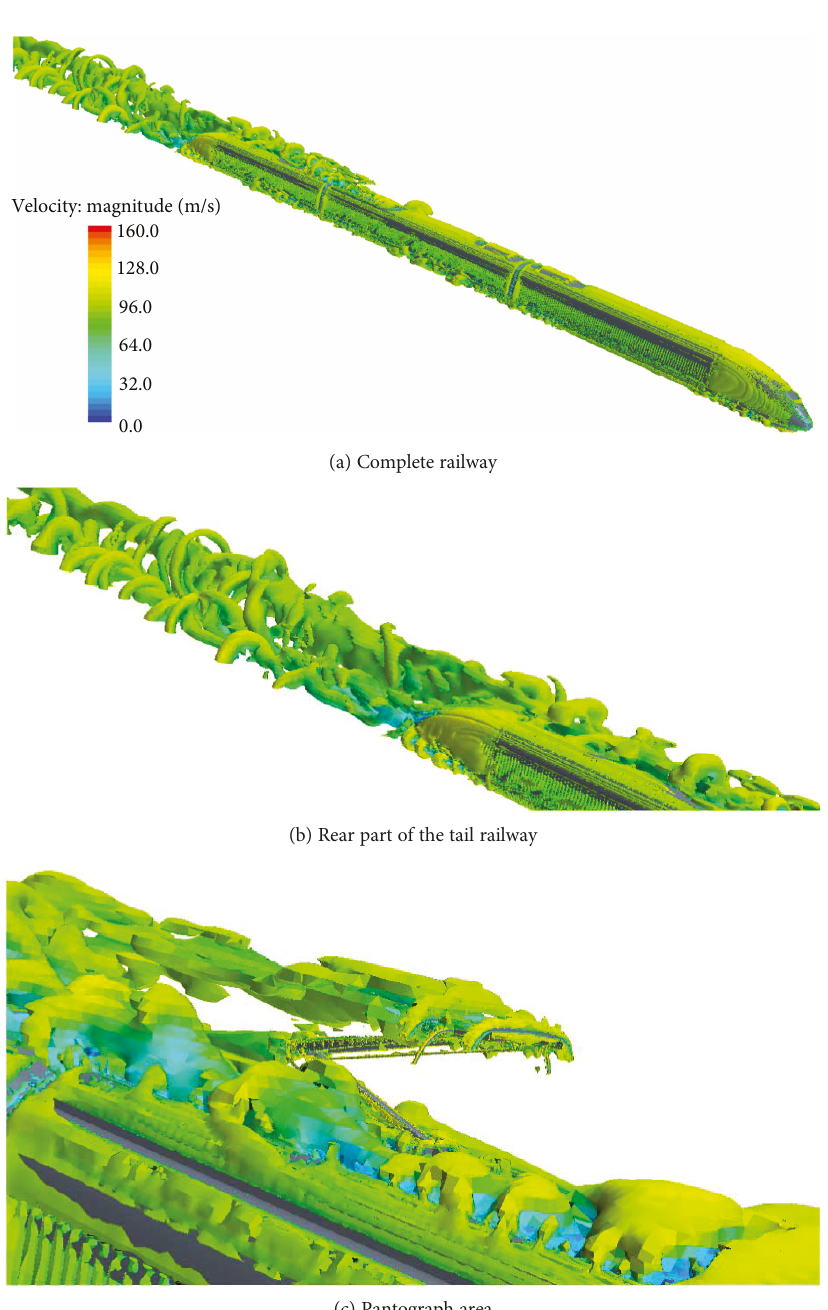
Figure 9: Vorticity distribution diagram of high-speed